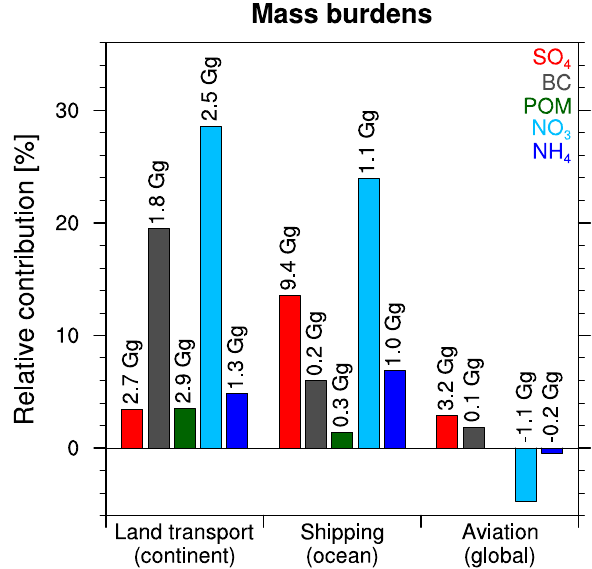
Fig. 3. Relative effects of the transport sectors on the multi-year av- erage global atmospheric mass burdens of different aerosol compo- nents in the two lowermost model layers ( ∼ 0–230m) for land trans- port and shipping (considering only mass burden over continents and oceans, respectively), and in model layers 7 to 9 ( ∼ 8–13km) for aviation. The relative effects are calculated as the relative contri- butions (REF–NOLAND)/REF, (REF–NOSHIP)/REF and (REF– NOAIR)/REF, for the three sectors, respectively, by consistently in- tegrating the burdens over the same domains. The value on top of each bar shows the corresponding absolute contributions. The plot- ted values are statistically significant according to a uni-variate t test (5% error